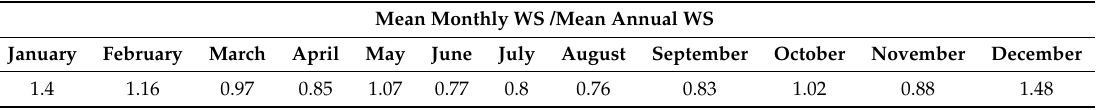
Table 4. Observed mean monthly wind speed normalized with observed mean annual wind